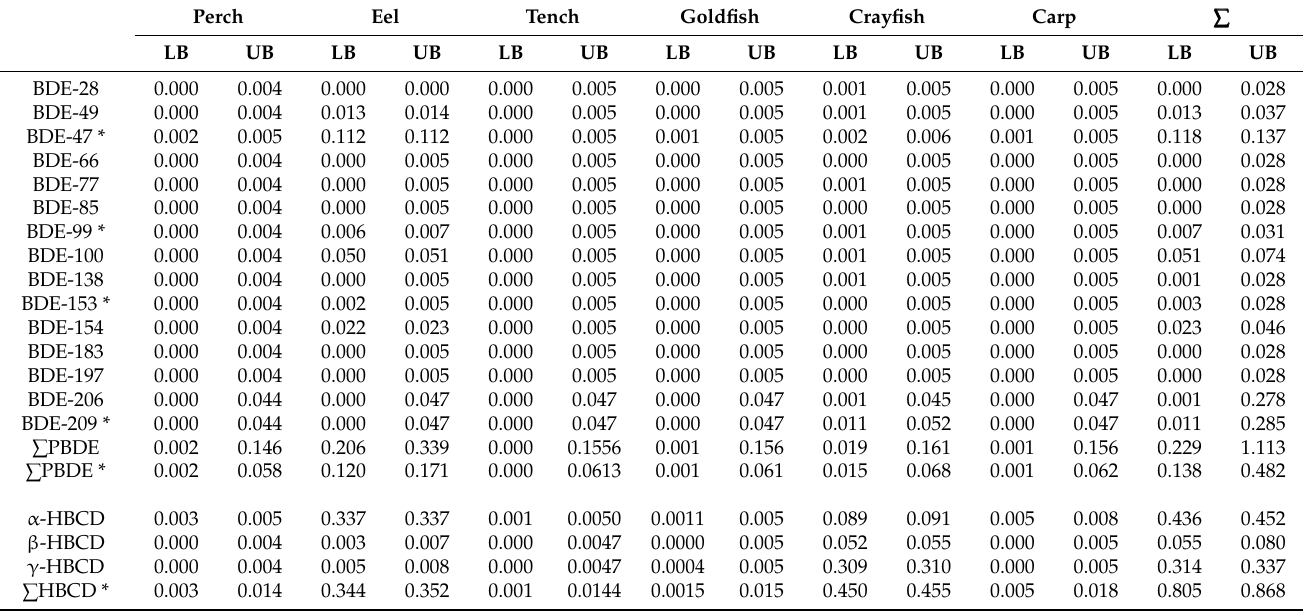
Table 2. Estimated daily intake (pg/kw